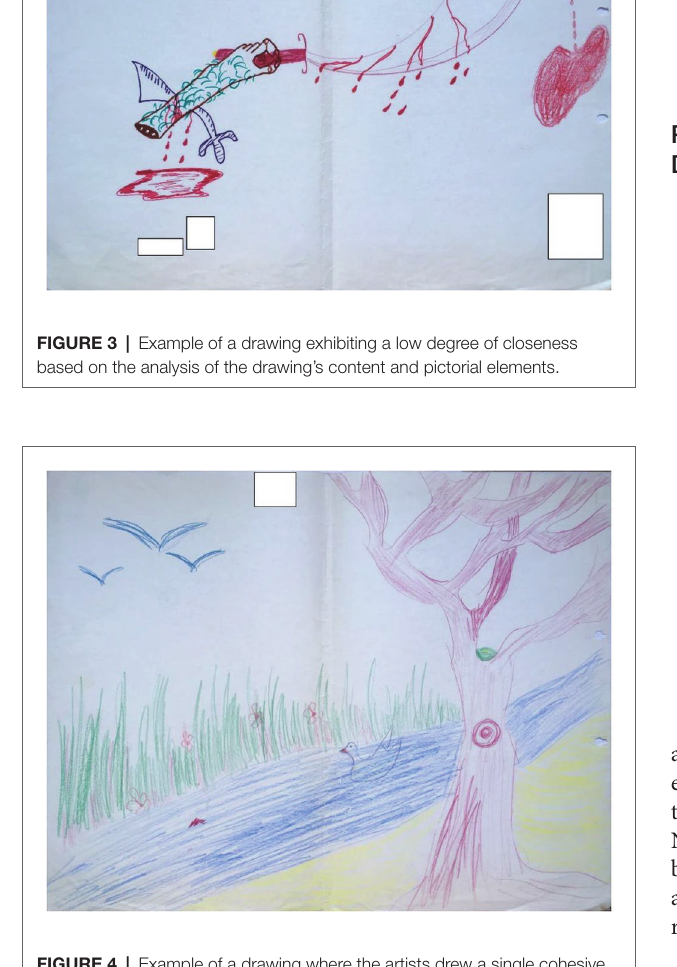
FIGURE 4 | Example of a drawing where the artists drew a single cohesive